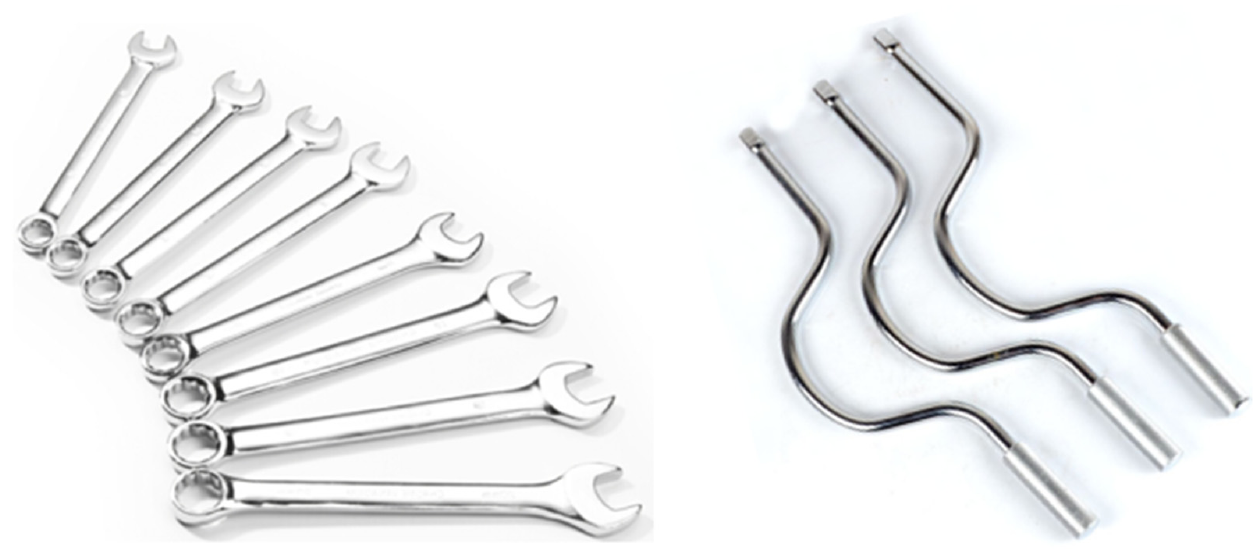
Figure 17. Ordinary wrenches and bow wrenches. The constant-torque wrench can apply a specific torque value to the bolt and adjust the tightening torque. Some constant-torque ratchet wrenches can achieve continuous tightening, and this function is related to the structure of the tightening head. The tightening torque control accuracy of the constant-torque wrenches varies depending on the brand, and the tightening torque is applied manually, so the actual torque value applied to the bolt fluctuates greatly. Figure 18 shows a constant-torque wrench used in the assembly of an aeroengine [89,90].